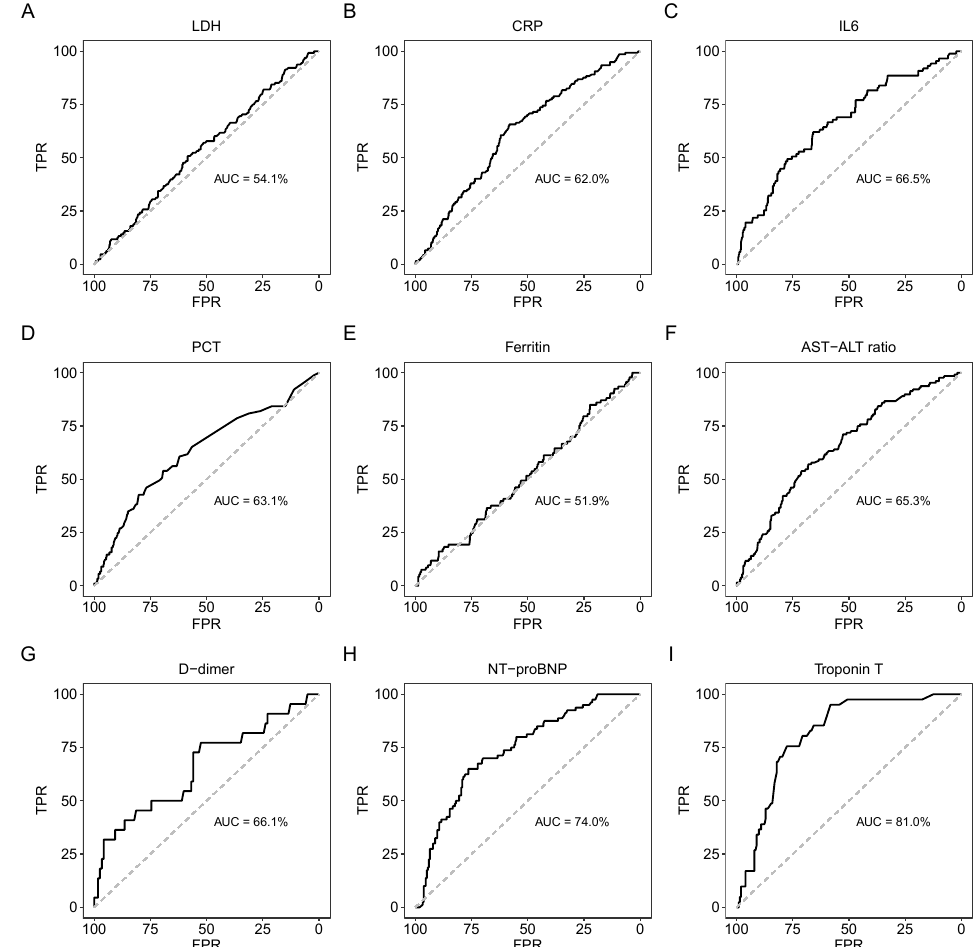
Figure 3. ROC curve plots of biomarkers with in-hospital mortality. In each subplot ( A – I ), grey diagonal line shows no predictive value and black line shows the actual predictive curve for each biomarker. Y axis represents TPR while X-axis represents FPR. AUC: area under the curve; TPR: true positive rate; FPR: false positive rate; LDH: lactate dehydrogenase; CRP: C-reactive protein; IL6: interleukin 6; PCT: procalcitonin; AST: aspartate aminotransferase; ALT: alanine aminotransferase; NT-proBNP: N-terminal pro-brain natriuretic peptide.